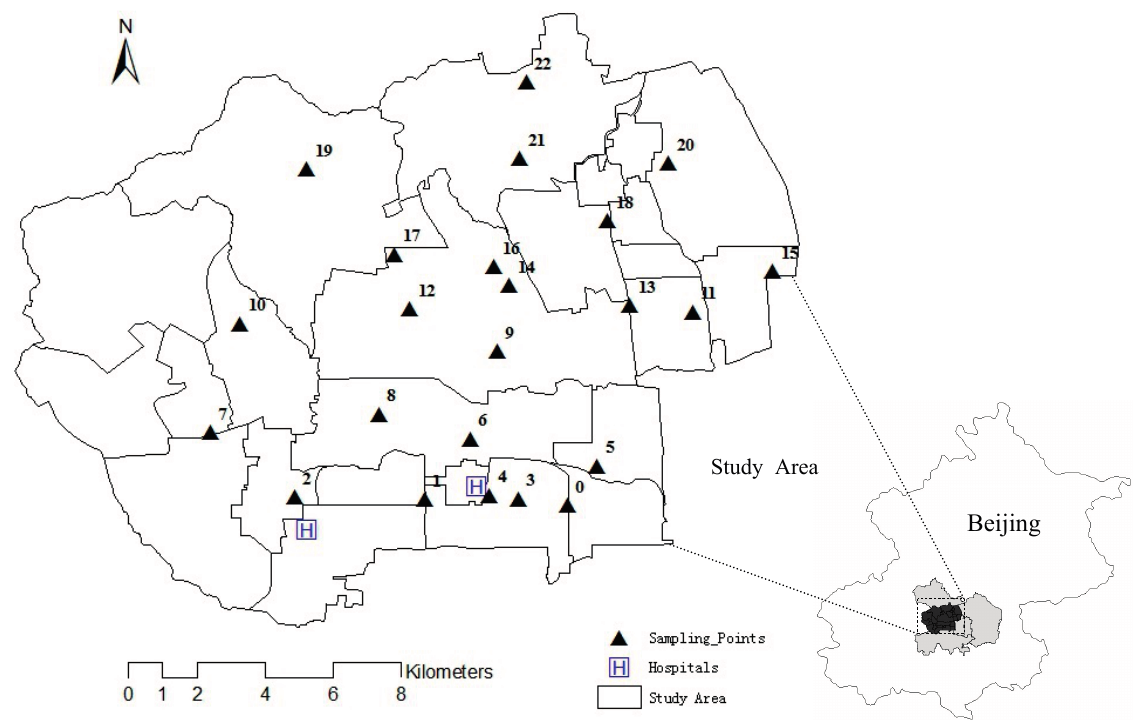
Figure 1. Study area and its